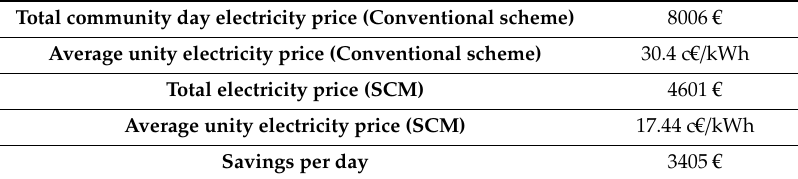
Table 4. Economic analysis of one-day OPF simulation (winter case).